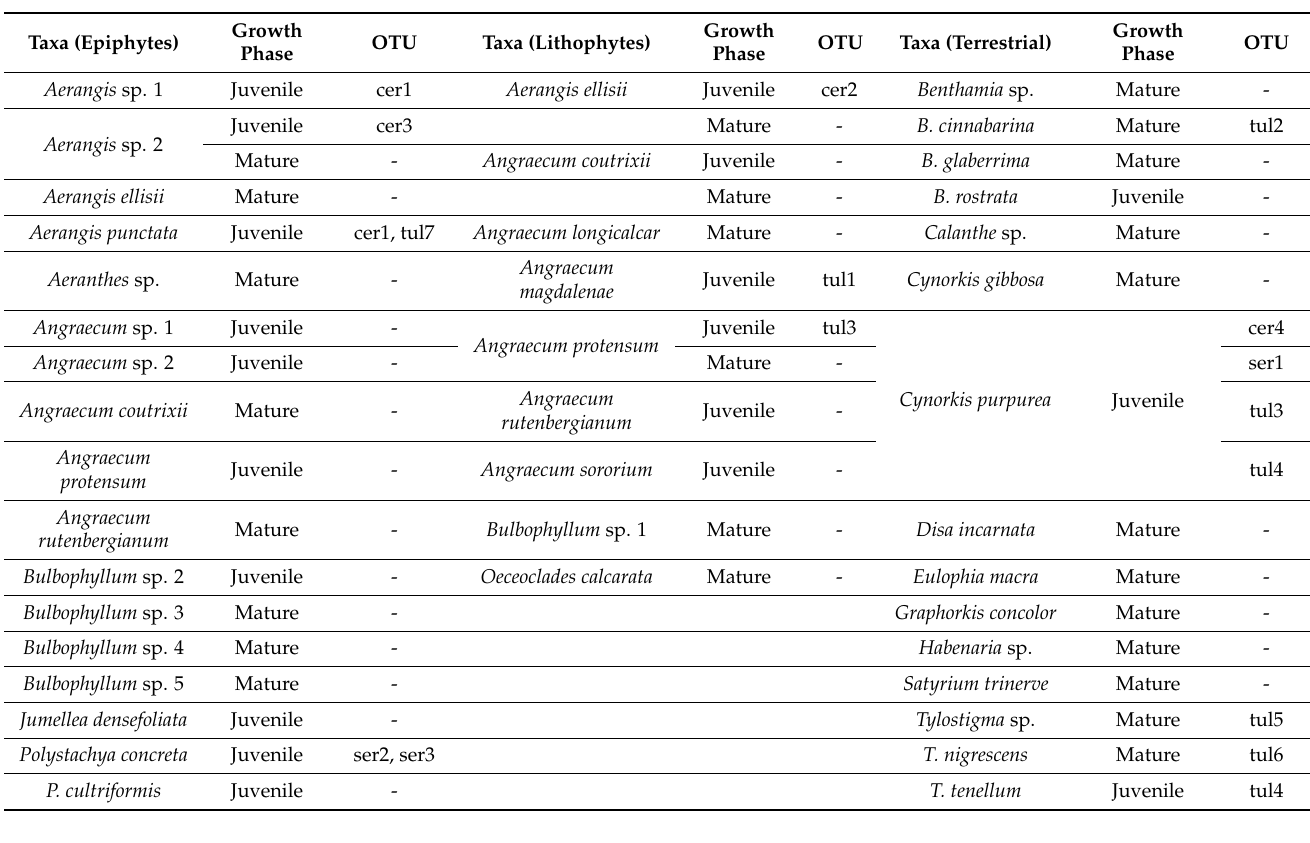
Table 1. Life form and growth phase of orchids collected during dry season and OTUs identified.